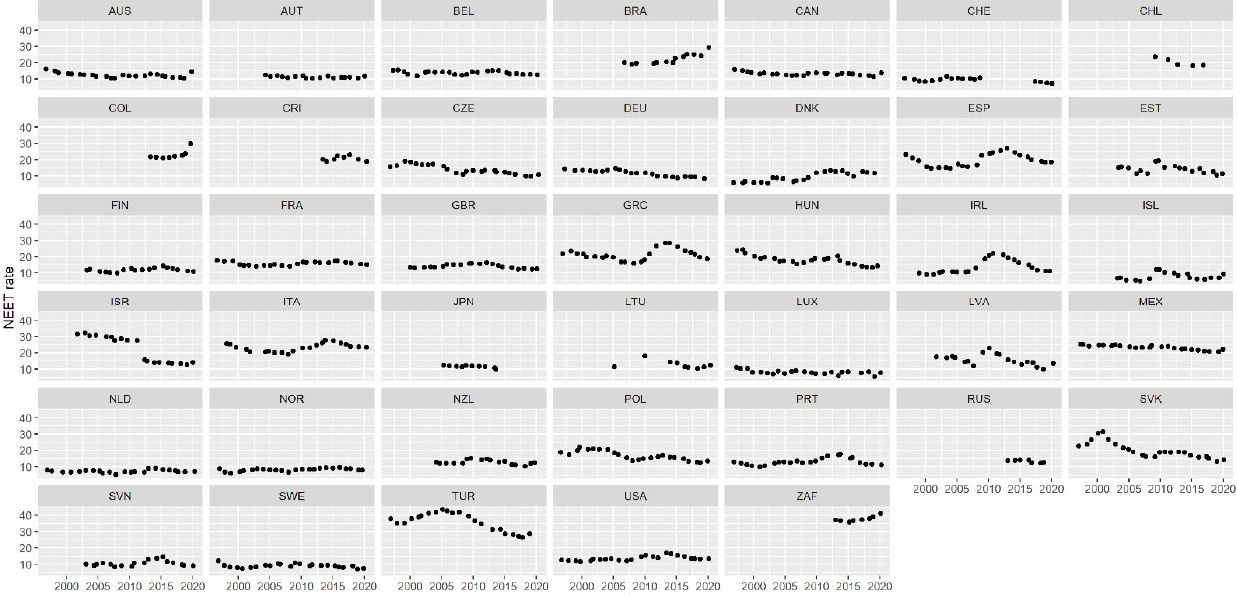
Figure 1. National trends in NEET rate for the 40 countries considered for analysis,